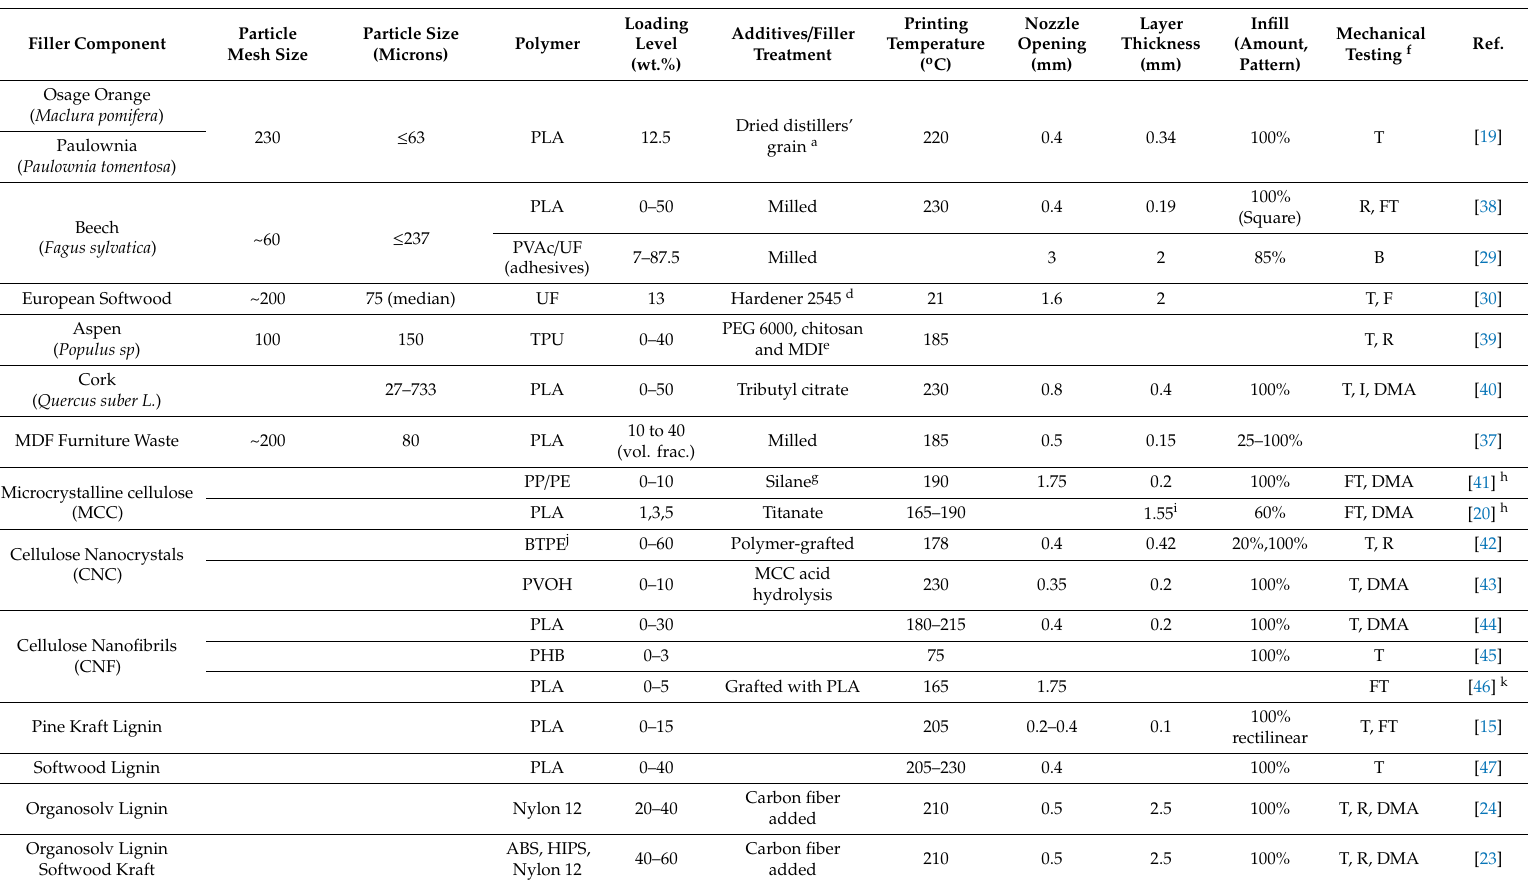
Table 2. Wood-based, including wood flours, sawdust, and barks, and lignocellulosic fillers used in materials extrusion AM processing. All samples were printed flat on the print bed with a default ( ± 45) infill pattern unless otherwise